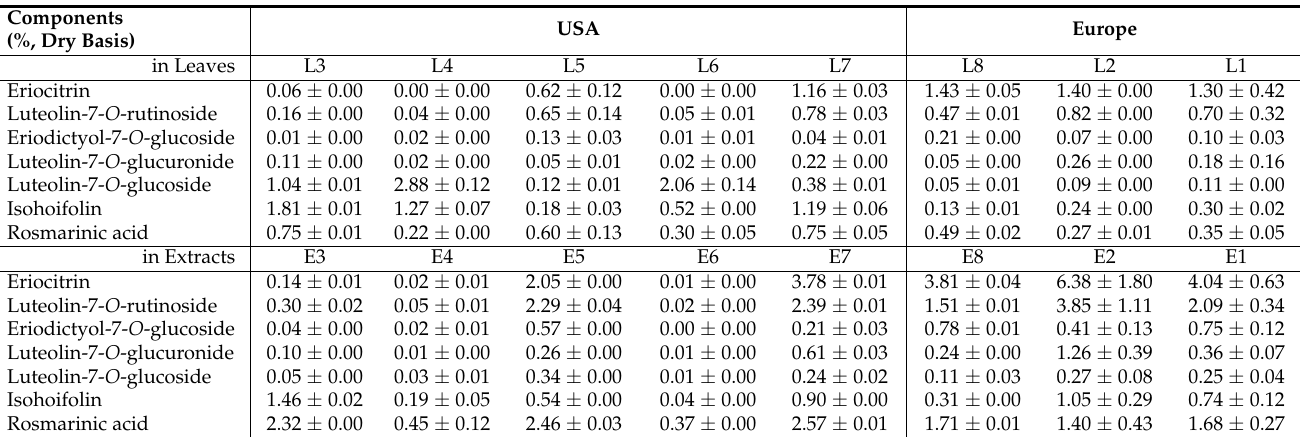
Table 3. HPLC–PDA analysis of the major bioactive components (%, dry basis) of peppermint proprietary leaf samples L1–L8 from USA and Europe, and corresponding extracts E1–E8. USA